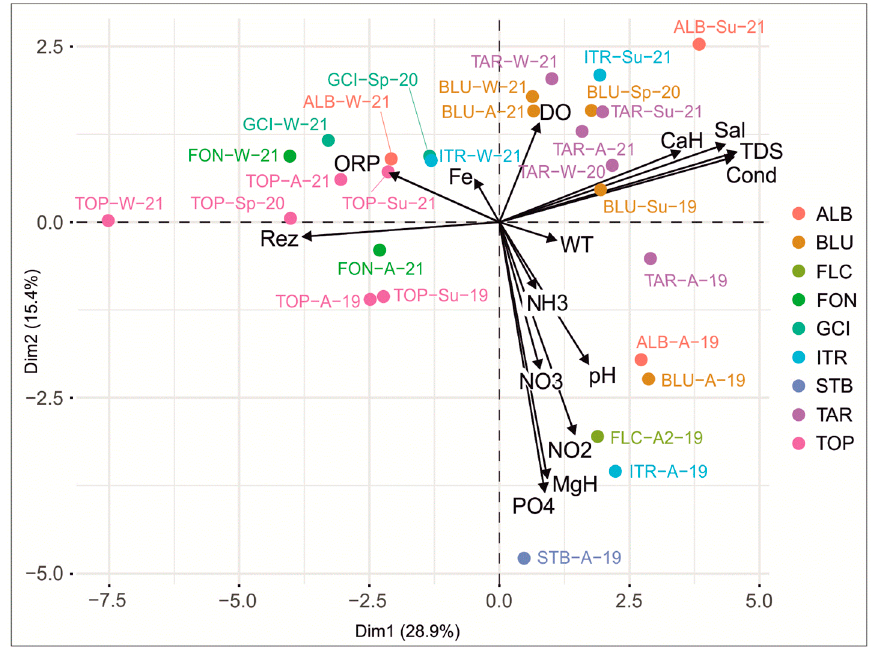
Figure 4. PCA biplot based on the physicochemical parameters of the freshwater samples. The three- letter acronyms correspond to the sampled freshwater sources (see Table 1); Sp = spring, Su = summer, A = Autumn, W = winter. Vectors represent variables used to build the principal components. Only samples that were projected greater than 0.5 cos 2 on the two axes are listed.